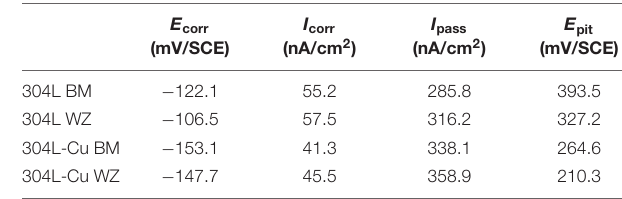
TABLE 2 | Fitting results derived from the potentiodynamic polarization curves in Figure 2 .